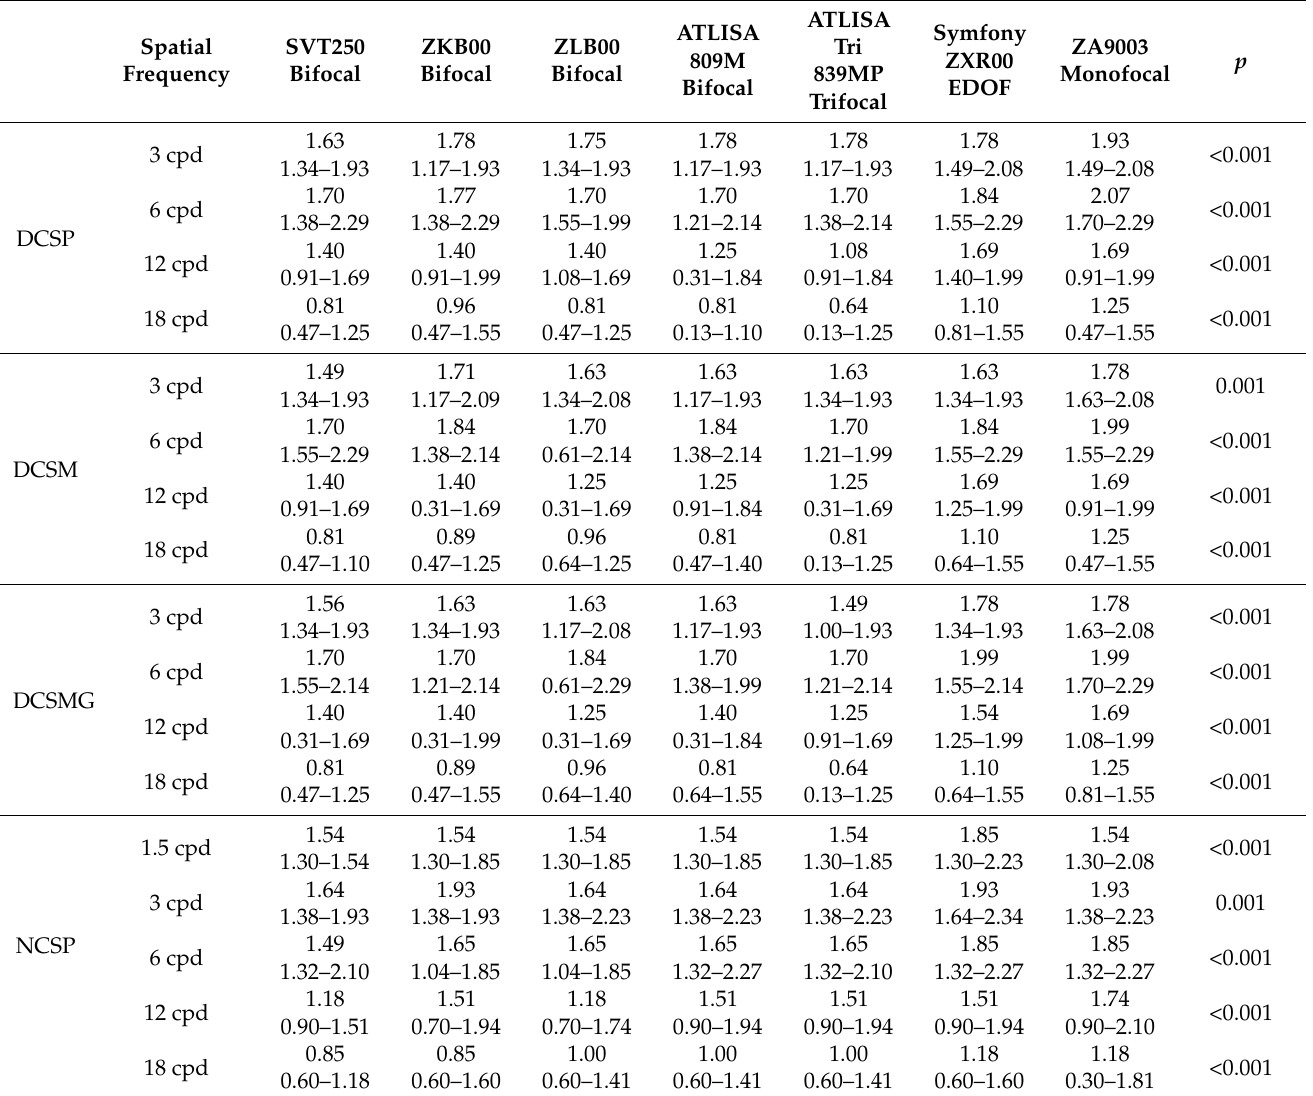
Table 3. Contrast sensitivity at distance (2.5 m) under photopic (DCSP), mesopic (DCSM) and mesopic with glare (DCSMG), as well as near (33–40 cm) photopic contrast sensitivity (NCSP). Median, maximum and minimum logarithmic values are presented for each lens group and spatial frequency (in cycles per degree, cpd). Also shown are the outcomes of the Kruskal–Wallis test of statistical significance ( p